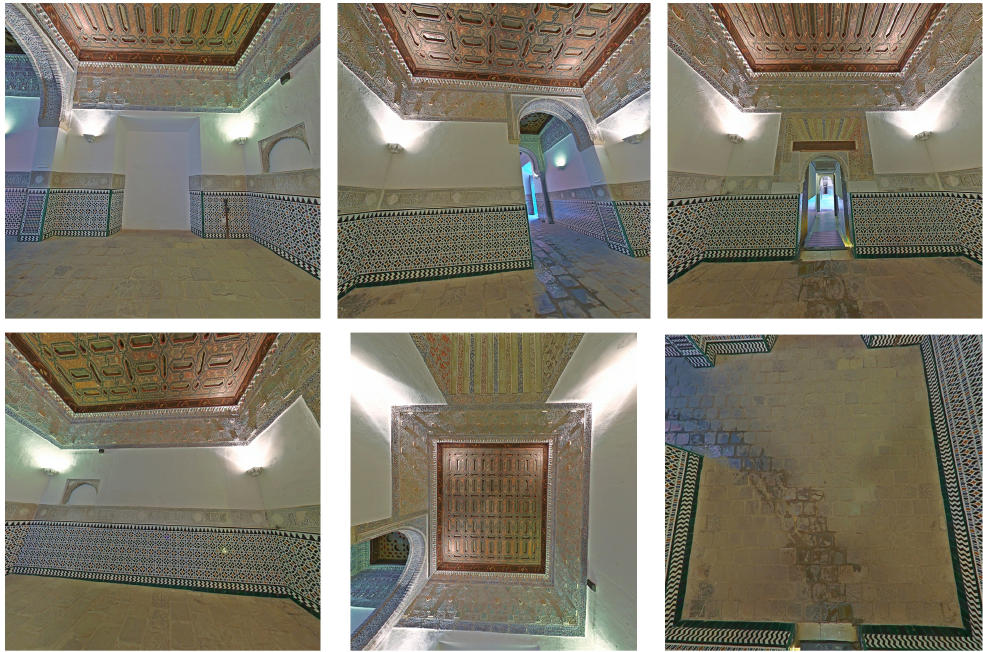
Figure 3. Six rectilinear images generated from a single spherical image using a gnomonic projection coupled with